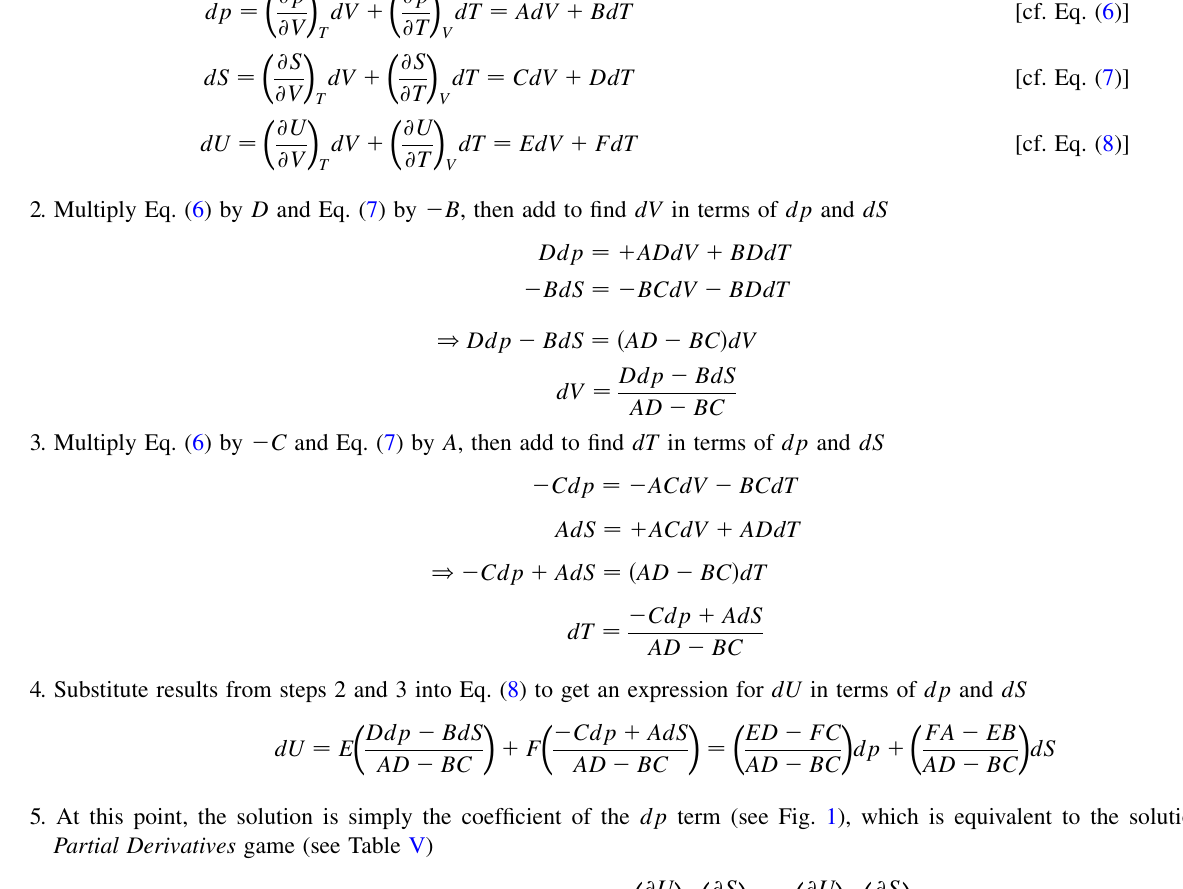
TABLE VI. Idealized example of the Differentials game (based on C. A. M.’s solution). 1. Find the differential for each equation of state [Eqs. (1)–(3)], either explicitly evaluating the derivatives or using placeholder names, as below dp ¼